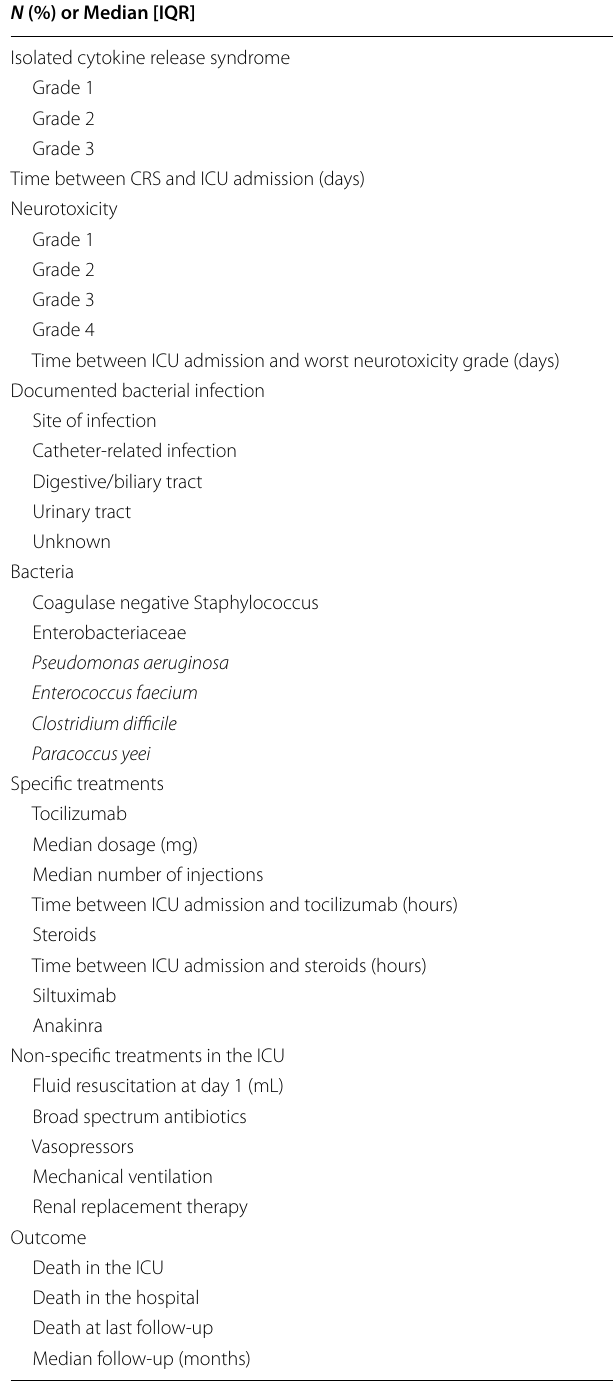
Table 2 CAR-T cell-related complications and management in the ICU